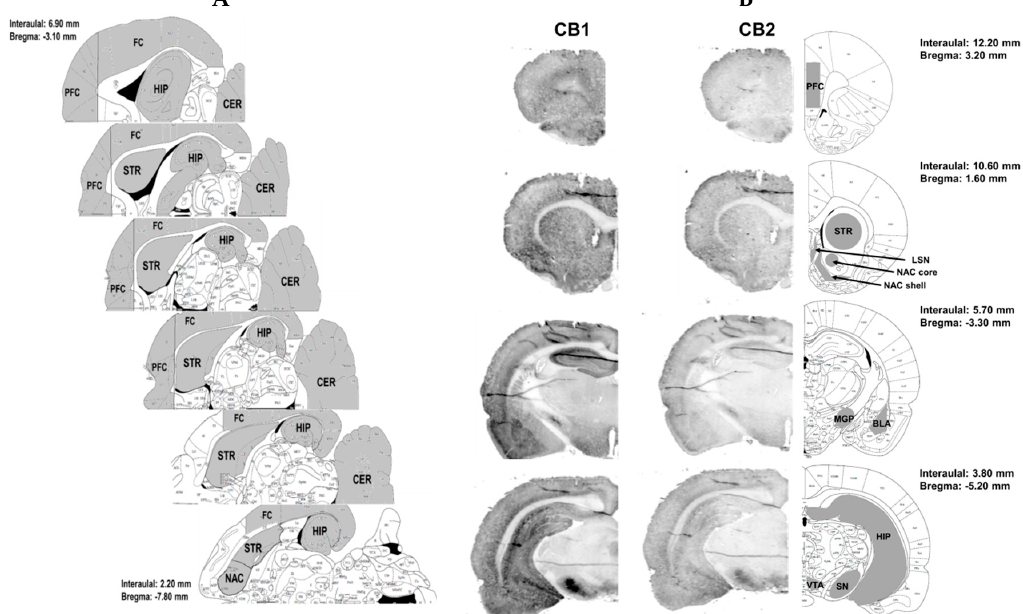
Figure 8. Illustration of rat brain structures for detection of level of endocannabinoid and NAEs (panel A ; horizontal section) or immunostaining of cannabinoid CB1 and CB2 receptors after passive saline administration, extinction training, and saline injection during reinstatement (Yoked saline + i.p. saline) (panel B ; coronal sections). BLA—basolateral and basomedial amygdala, CER—